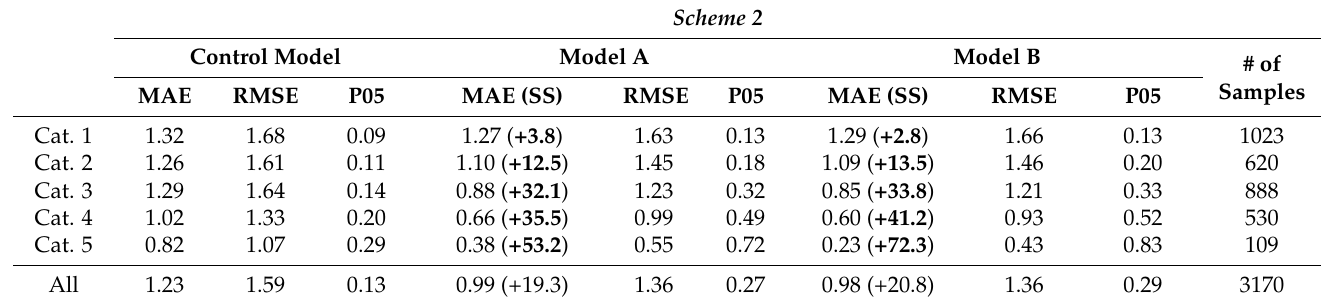
Table 5. Evaluation results of scheme-2 -based tropical cyclone center estimation. Scheme 2 used the real-time reports issued from the Korea Metrological Association 6 h prior. The unit of ME, MAE, and RMSE is degree ( ◦ ), and P05 is unitless. The unit of SS is percentage (%), and it implies the improvement of the model A and B compared to the control model based on SCBeM . The improved cases are shown in